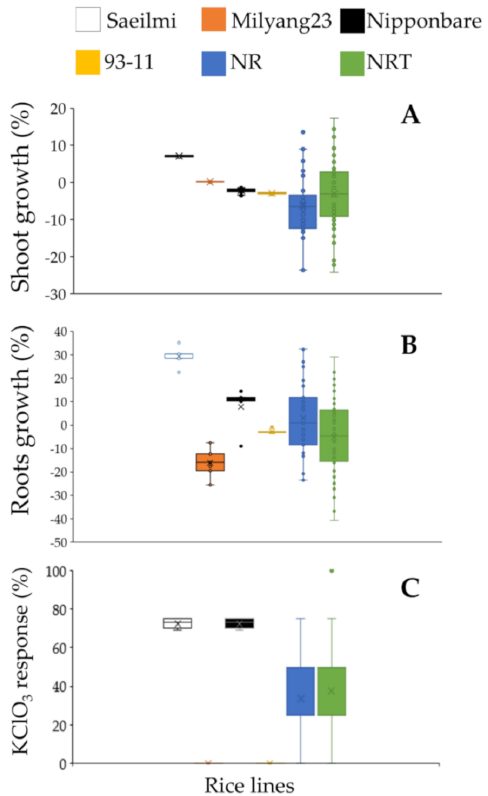
Figure 1. Genotype–phenotype correlation of the nitrate reductase and nitrate transporter introgres- sion lines and parental line in response to potassium chlorate (KClO 3 ). ( A ) The box plots display the shoot growth patterns of the Saeilmi (P1, japonica ), Milyang23 (P2, indica ), Nipponbare (typical japonica cultivar), 93-11 (typical indica cultivar), nitrate reductase (NR, n = 26), and nitrate transporter (NRT, n = 59) introgression lines. ( B ) Box plots showing the root growth patterns, and ( C ) the KClO 3